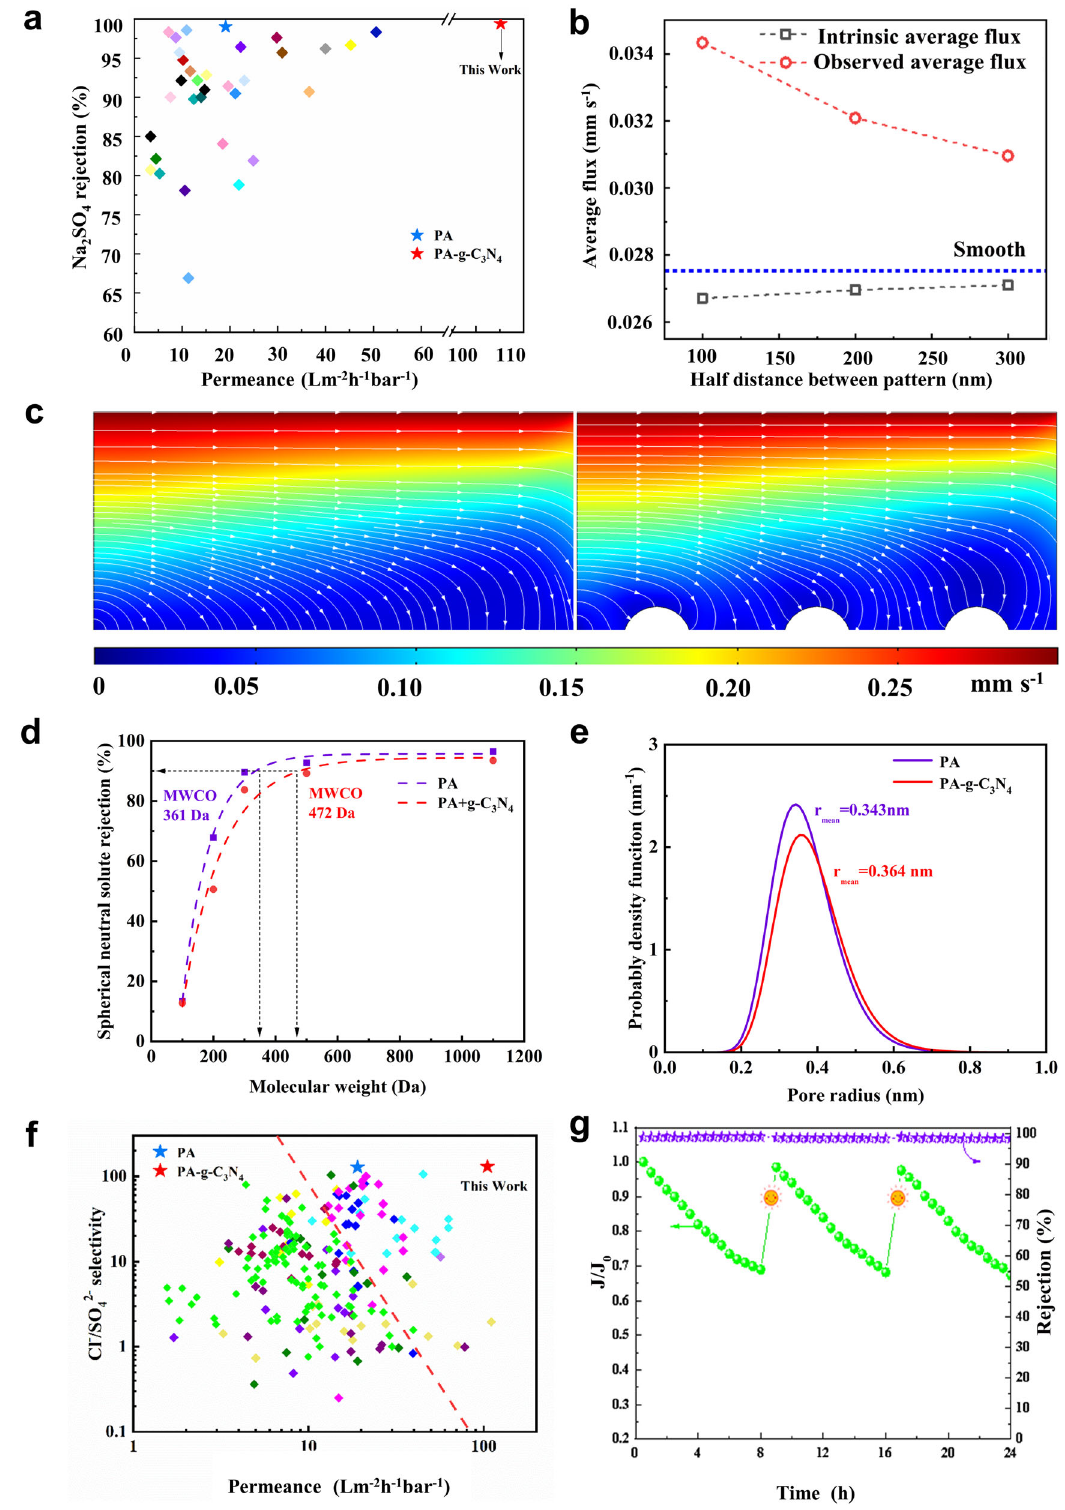
Fig. 4 | Separation performances ofNF membranes.a Performance comparison of PA-g-C 3 N 4 with state-of-the-art NF membranes. Literature data are obtained from ref. 3 . b Average fl ux of different half distances between patterns. c Comparison of the fl ow streamlines of smooth and nanoscaleordered structure. d MWCOsof thePAand the PA-g-C 3 N 4 membrane. e Meanporesize of the PA and